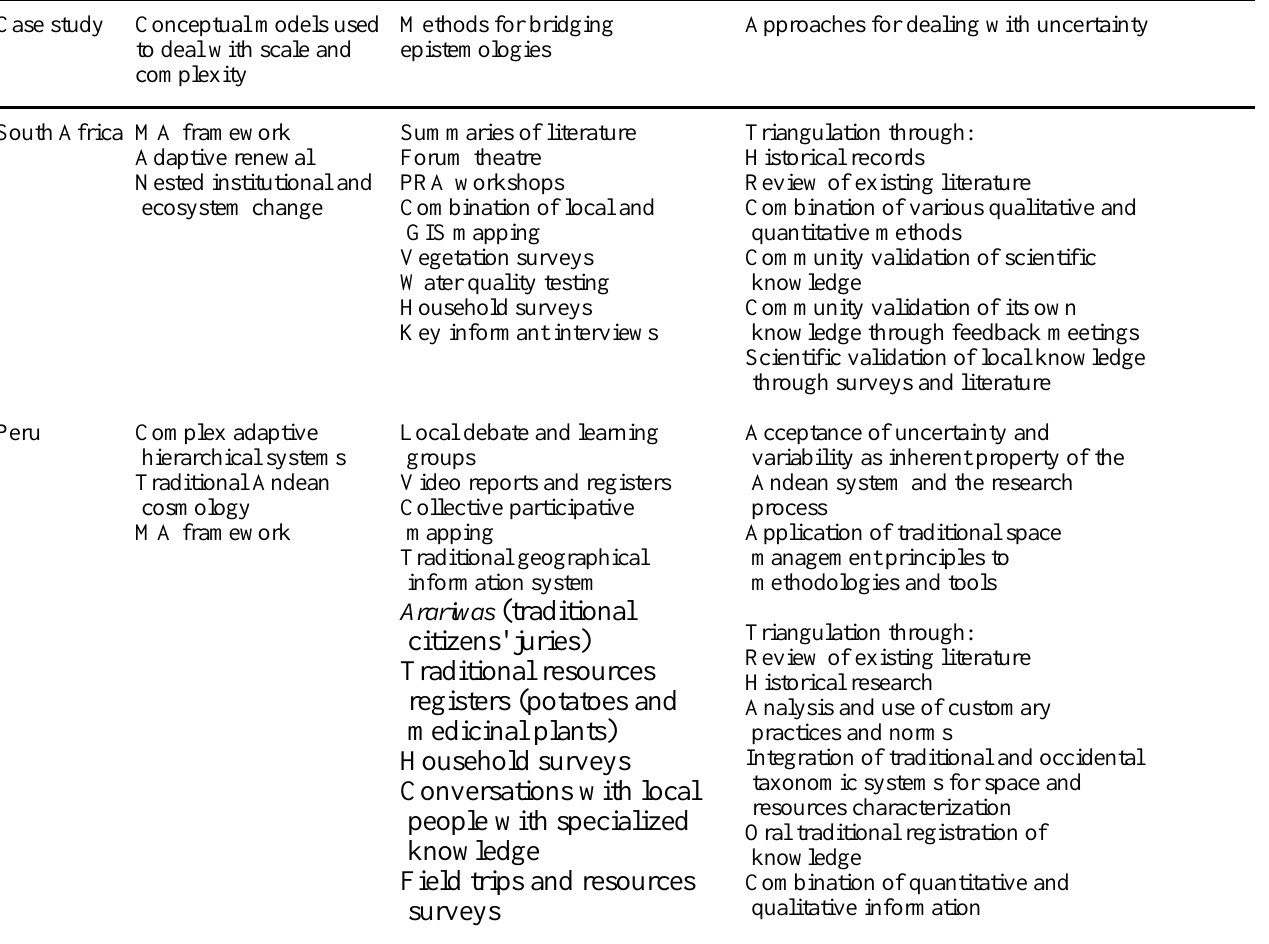
Table 2 . Summary table of approaches followed by the South African and Peruvian case studies. MA stands for Millennium Ecosystem Assessment, PRA for participatory rural appraisal. Case study Conceptual models used Methods for bridging Approaches for dealing with to deal with scale and epistemologies complexity